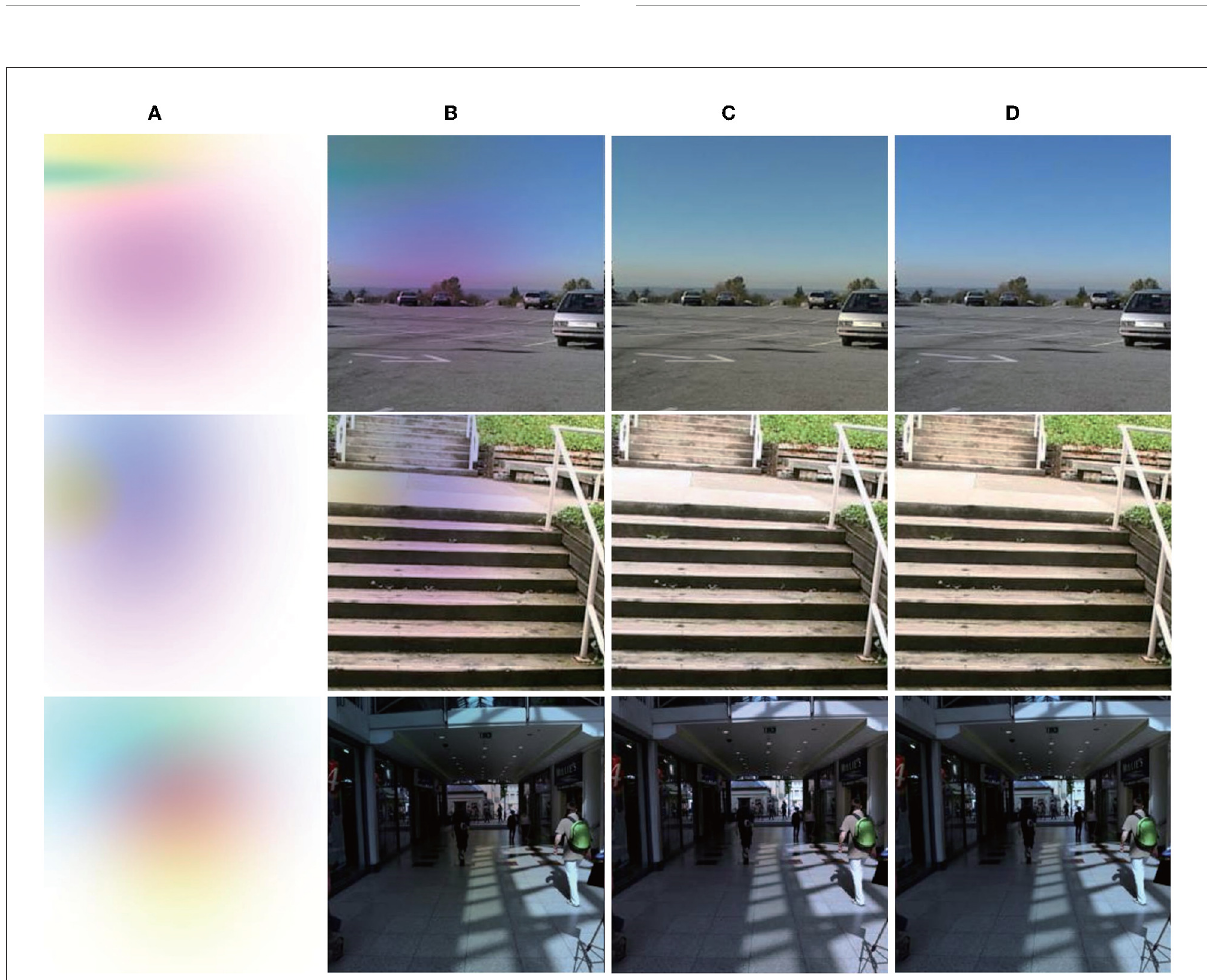
FIGURE6 Results produced by the proposed approach on removing of multi-illuminant color cast, the images come from SFU Gray-Ball (Ciurea and Funt, 2003). From left to right: (A) Tint maps; (B) Synthesized images; (C) Predictions; (D) Ground truth. Dataset available at: https://www2.cs.sfu.ca/~ colour/data/gray_ball/index.html. Reproduced with permission from Ciurea and Funt